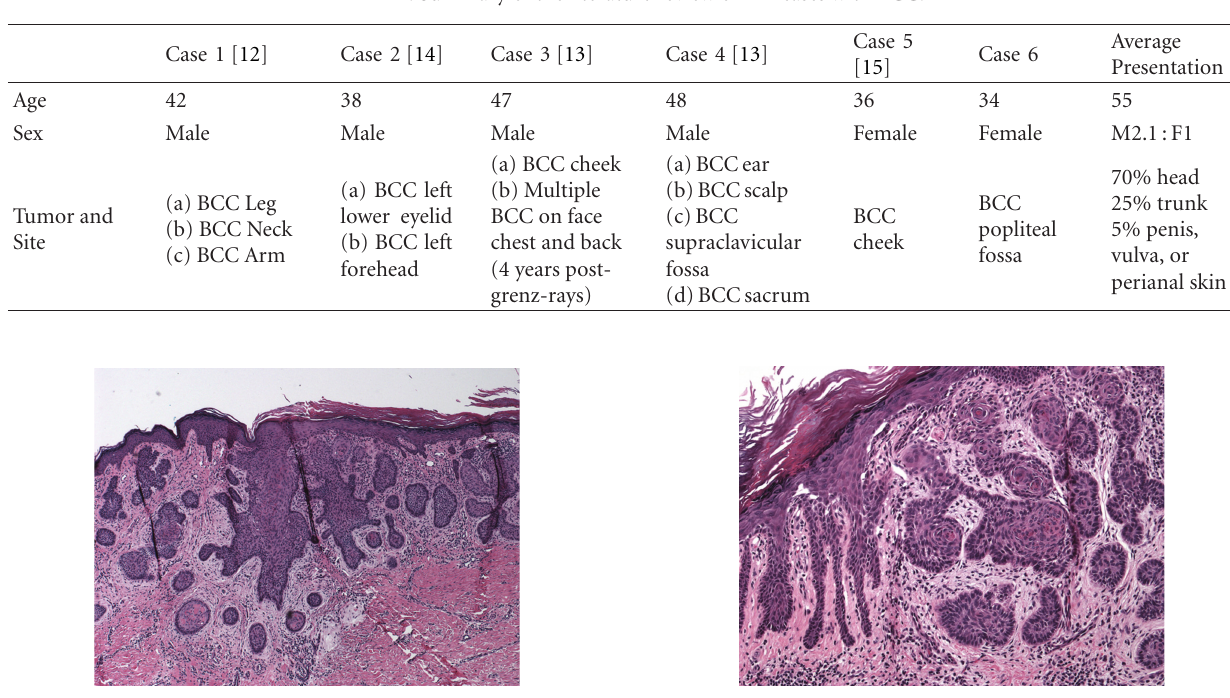
Table 2: Summary of the literature review of DD cases with BCC.